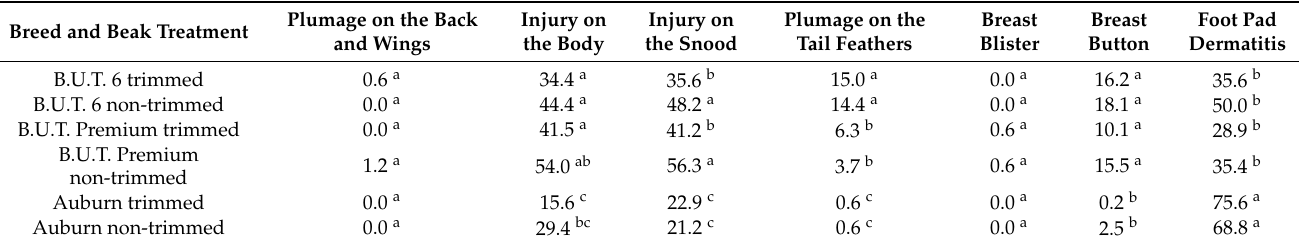
Table 5. Rating of the examined animal welfare indicators in percentage (%) of turkeys ( n = 192) with alterations or injuries (> Sore 0) on the assessed body parts after Phase 6 (137th DOL).